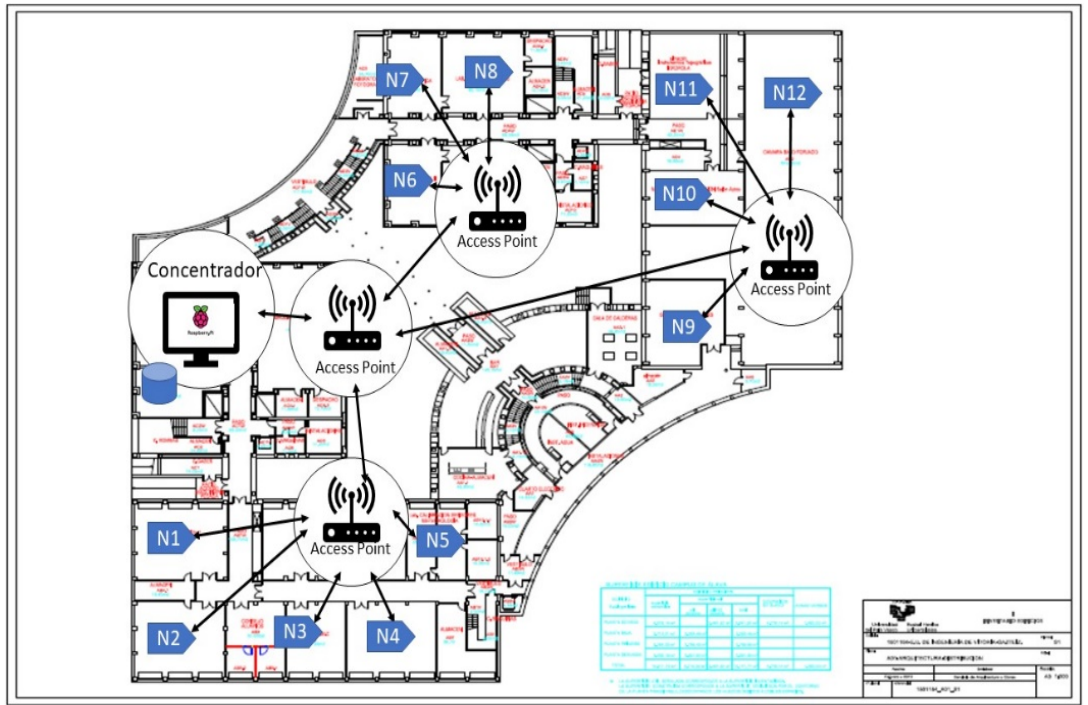
Figure 8. Distribution of the smart sensors at the Faculty of Engineering of Vitoria-Gasteiz (UPV/EHU).